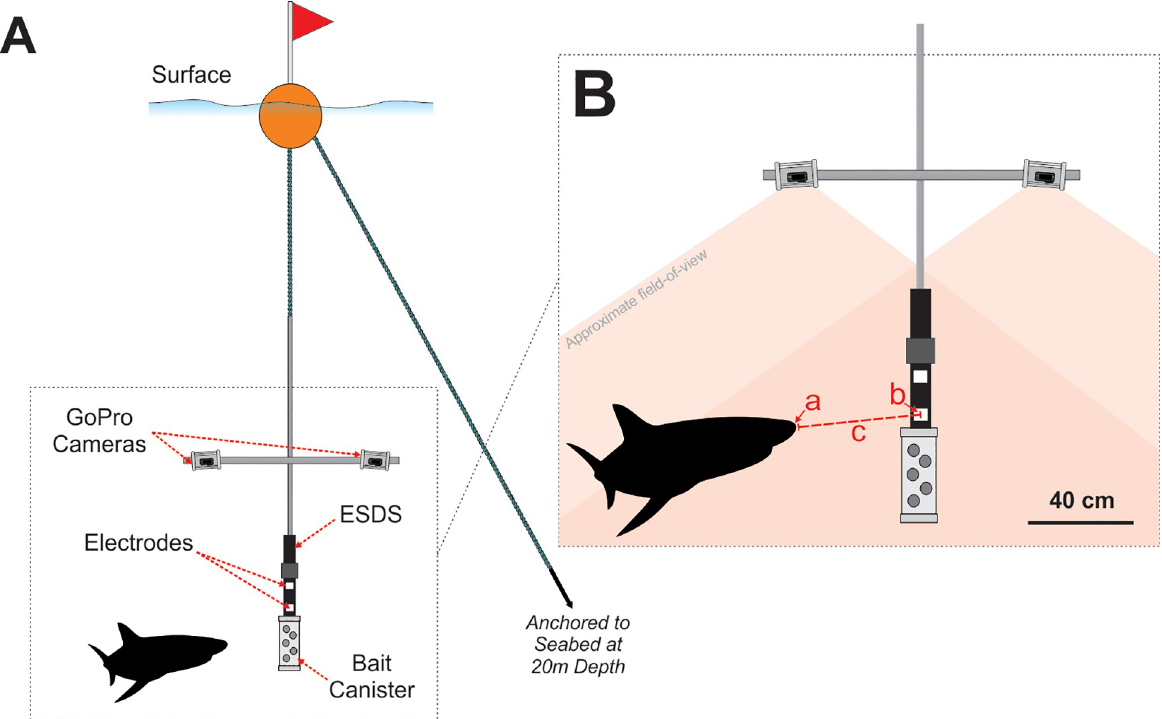
Fig 2. Diagram of a Remote Monitoring Research Apparatus (ReMoRA). (A) shows the ReMoRA in its deployed configuration with downward-facing cameras. (B) shows the measurements recorded to calculate proximity of C . carcharias to the ESDS electrode closest to the bait canister. Using Event Measure software, the closest part of a shark’s head to the electrode is marked via the left and right cameras (a), and then the centre of the ESDS electrode is also marked (b), which accurately calculates the closest observable proximity of the shark in three-dimensional space (c), taking into account both the vertical and horizontal axis. For clarity, the electrodes of the ESDS are displayed in white to highlight their